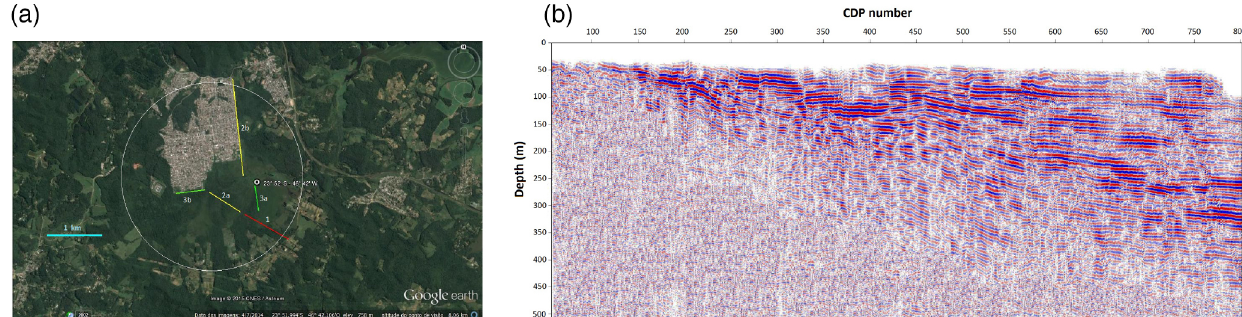
Figure 5. (a) Satellite view of the structure of Colônia showing the location of the 2010 seismic section (red line) and the sections planned for 2015. (b) Results of the 2010 seismic section along the Colônia structure (common depth point (CDP) trace interval = 1m). The bright red and blue colours show the uninterpreted sedimentary infill of the basin(from Riccomini et al.,